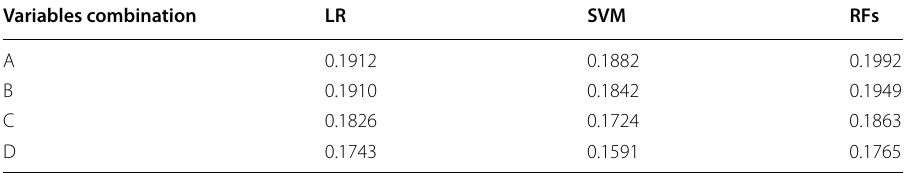
Table 6 Mean square errors of different predictive models Variables combination LR SVM